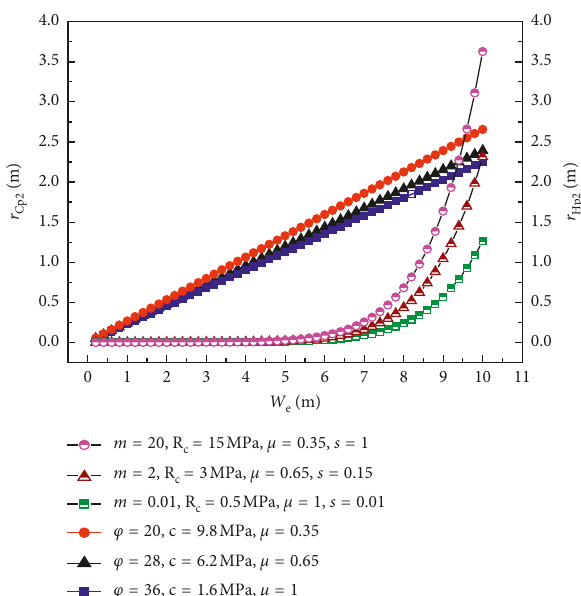
Figure 6: The influence curve of damaged width of rib pillar by the width of